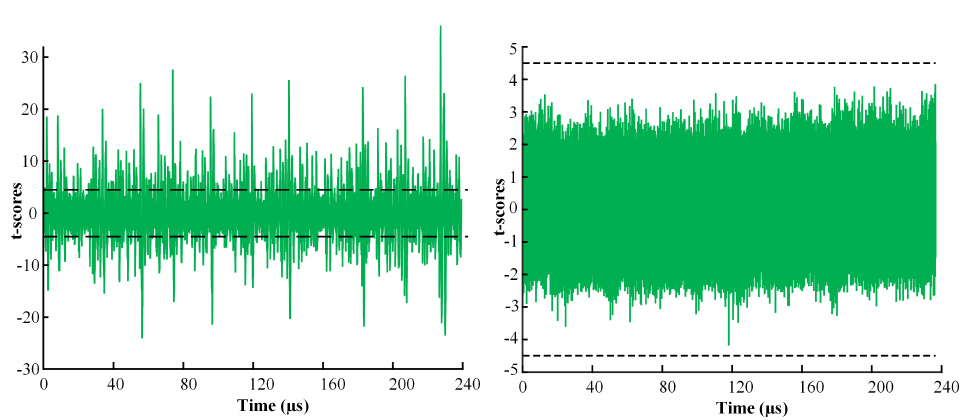
Figure 19: TVLA results of the masked MLP hardware with 10M traces (right). This is evaluated for a small window randomly selected from the overall inference window. The results show that even with an increased number of measurements there is no first-order leakage . The figure on the left is the plot with PRNGs switched off for the same